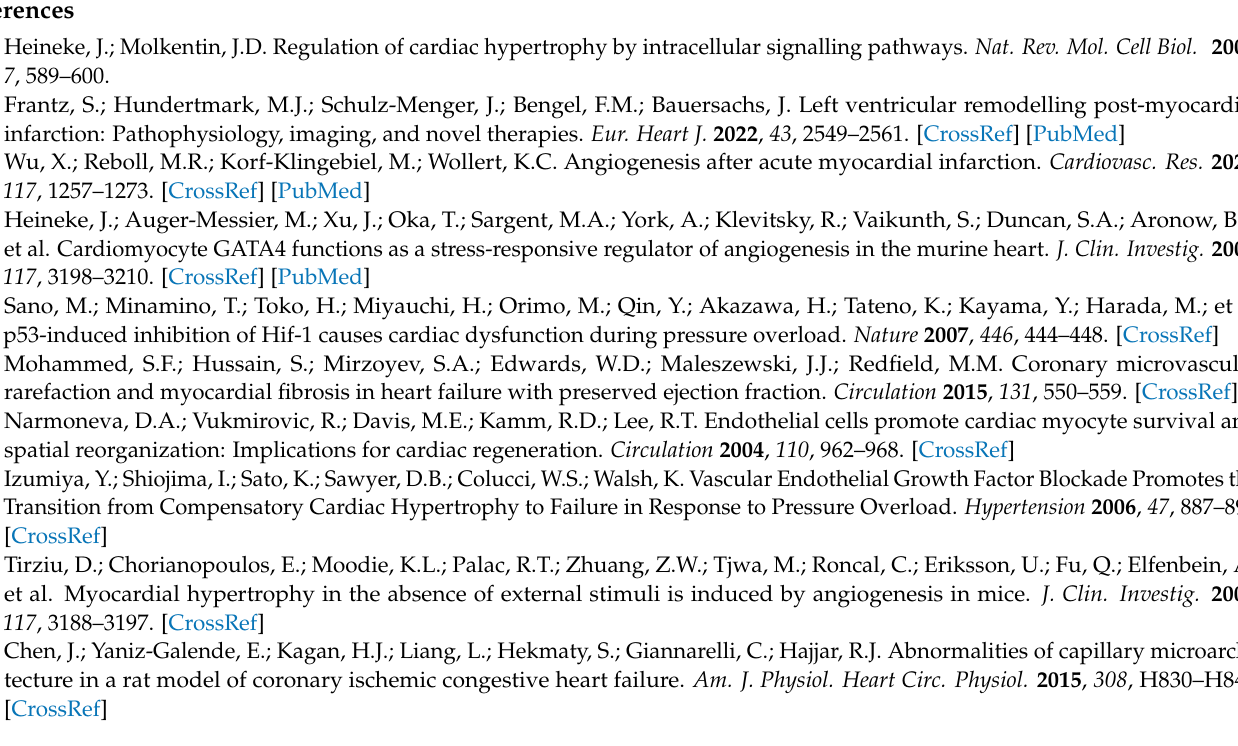
in GATA2 mutant mice; Figure S3: Micro-array analysis of endothelial gene-expression in cardiac endothelial cells of control and G2-EC-KO mice after TAC; Figure S4: Micro-array analysis of whole hearts of control and G2-EC-KO mice after TAC; Figure S5: Short open reading frames in the GADLORs; Figure S6: Signal transduction in cardiomyocytes during GADLOR